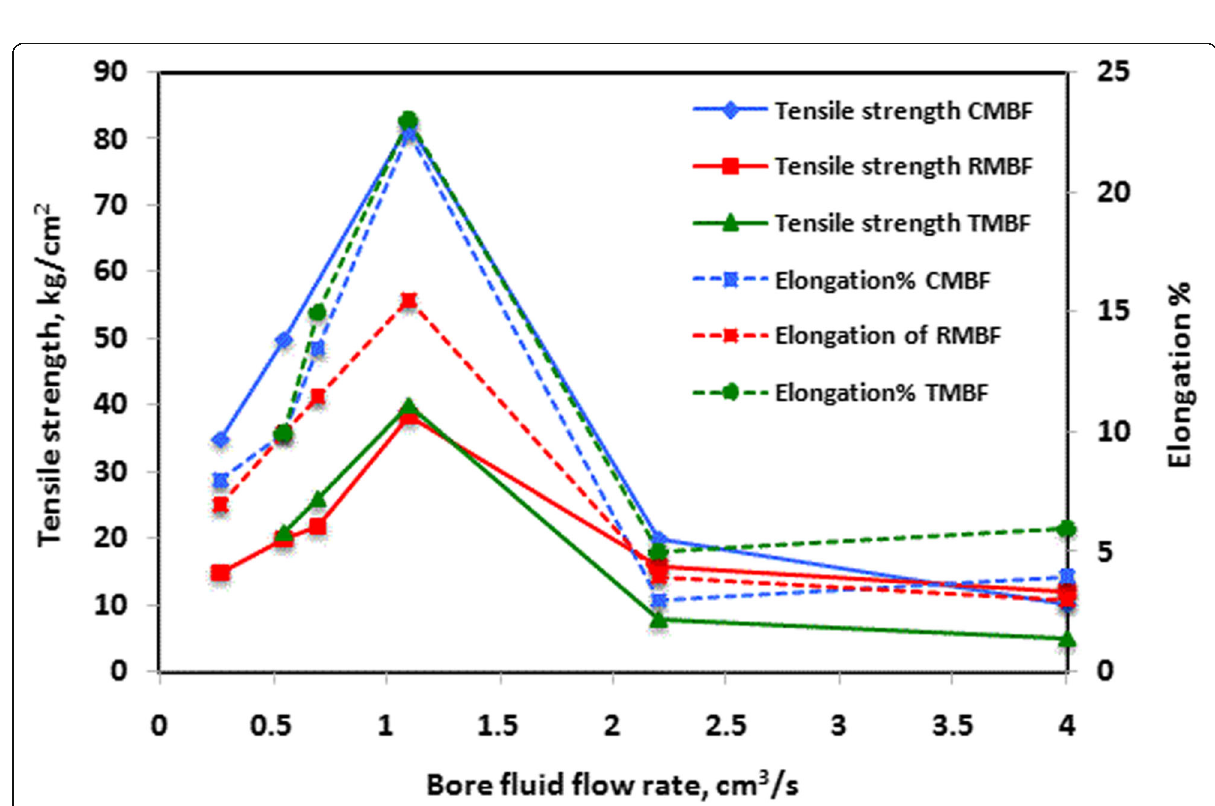
Fig. 15 Effect of bore fluid flow rate on the tensile strength and elongation % at different